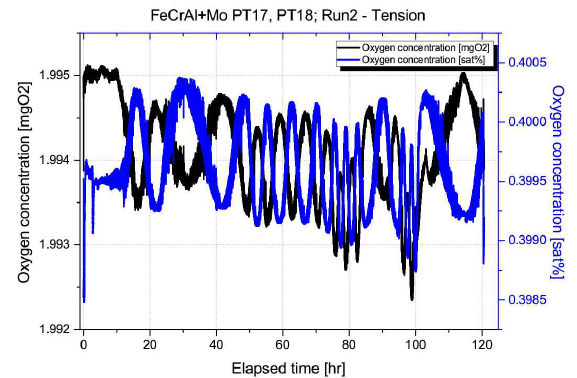
Figure 13. FeCrAl+Mo Run 2 - oxygen concentration.